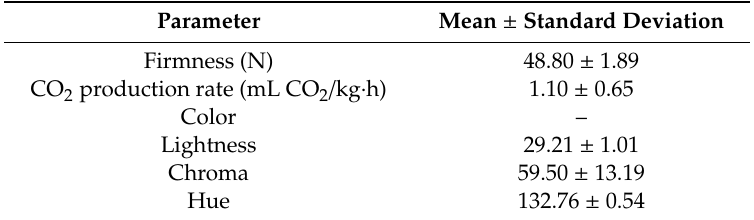
Table 1. Firmness, CO 2 production, and color of